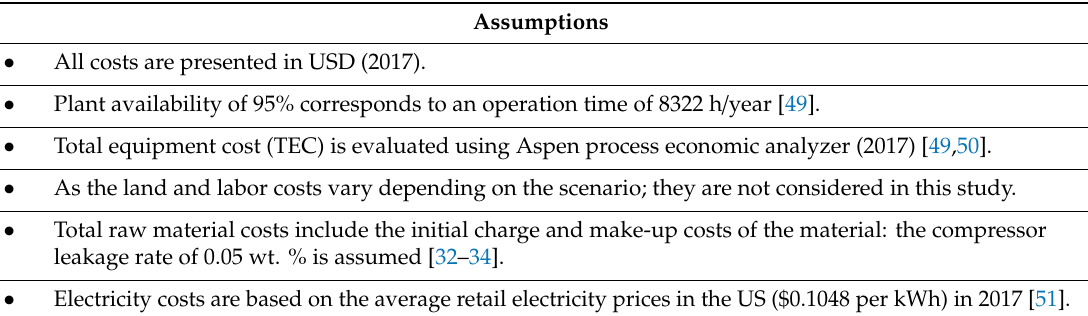
Figure 5. Cost estimation framework. Table 4. Assumptions for economic analysis.